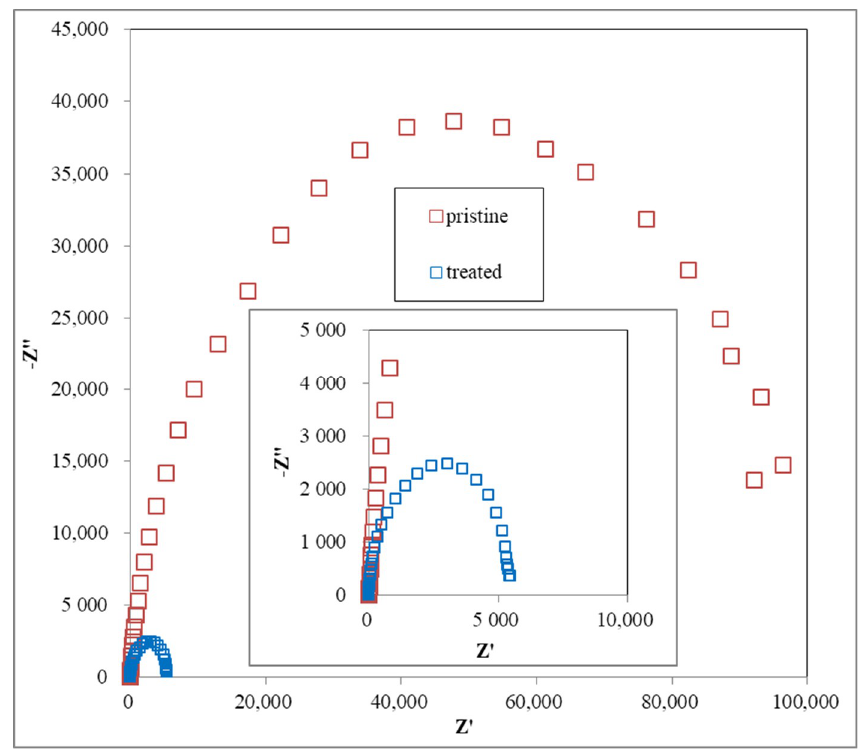
Figure 7. The Nyquist plots of the compared electrochemical impedance spectroscopy (EIS) results.